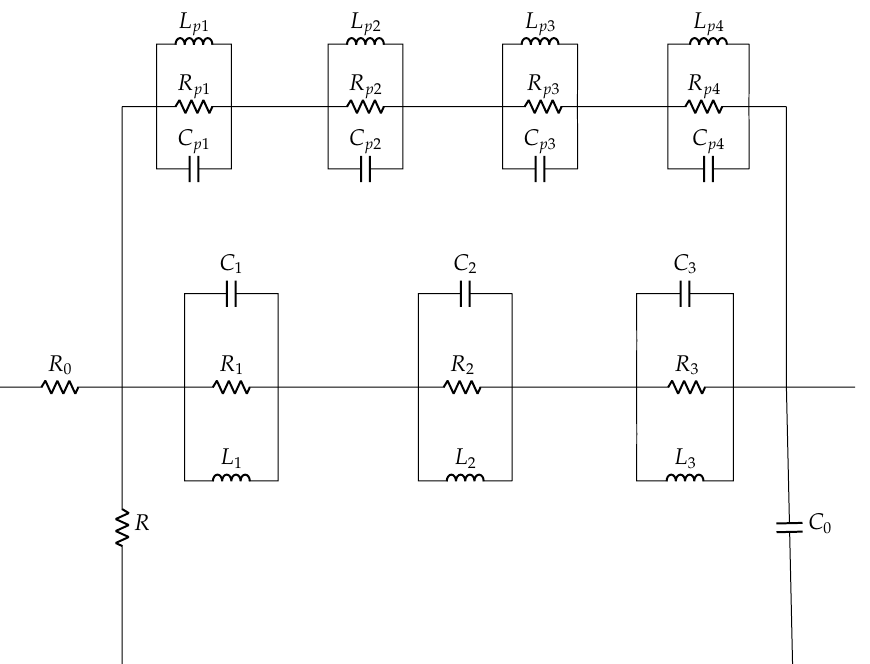
Figure 20. Equivalent circuit model of PZT-27 with mechanical load.